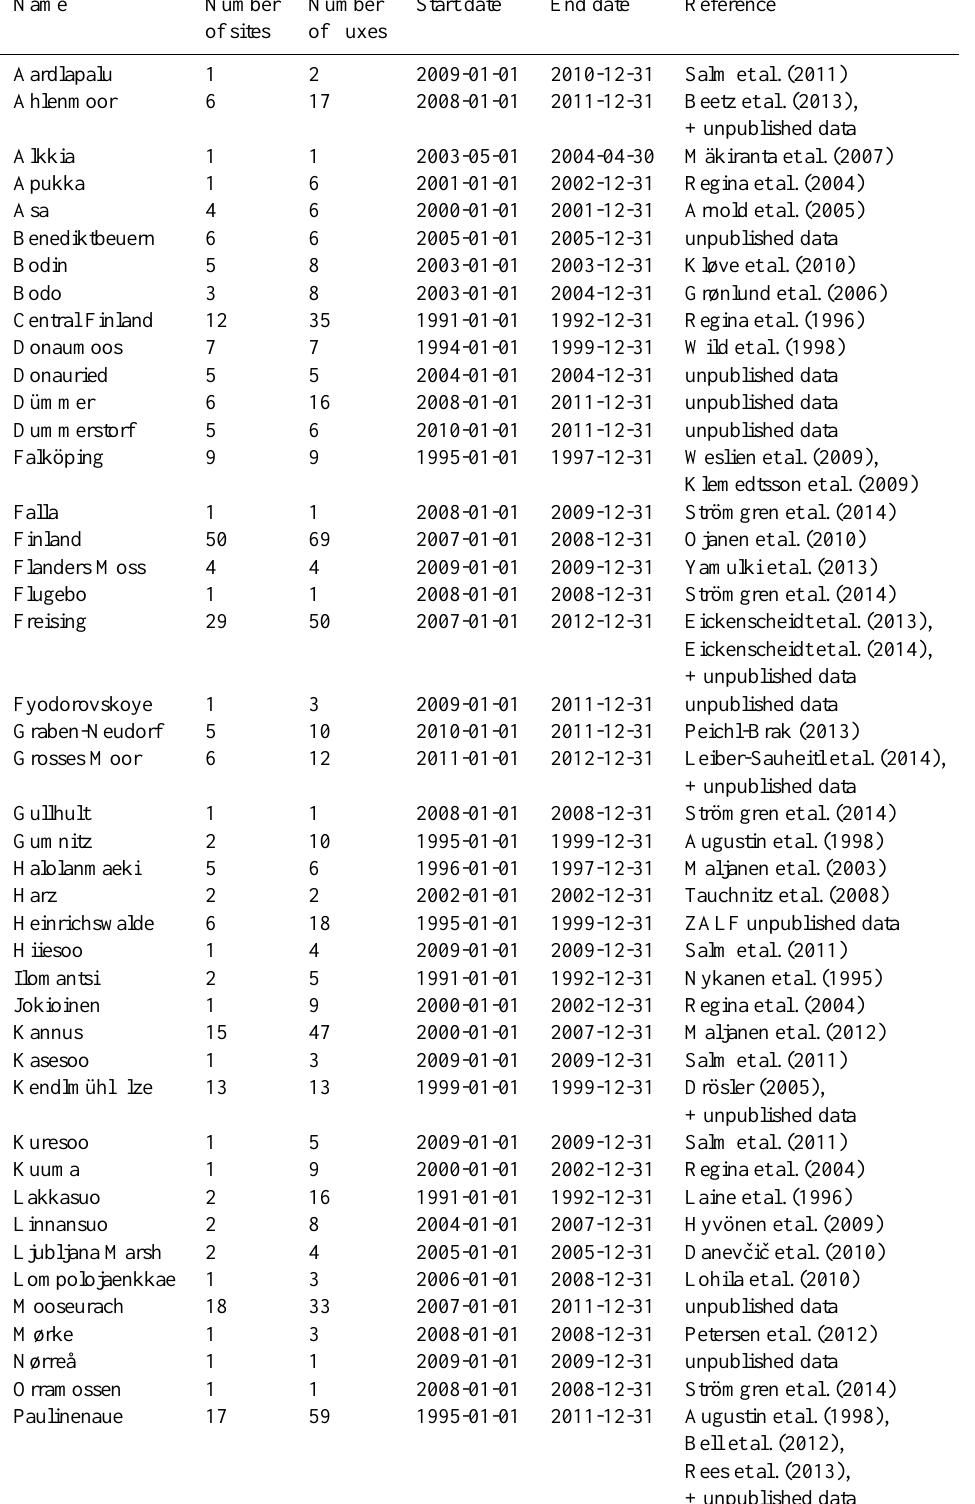
Table 6. List of sites with number of flux measurements and references that are included in the presented